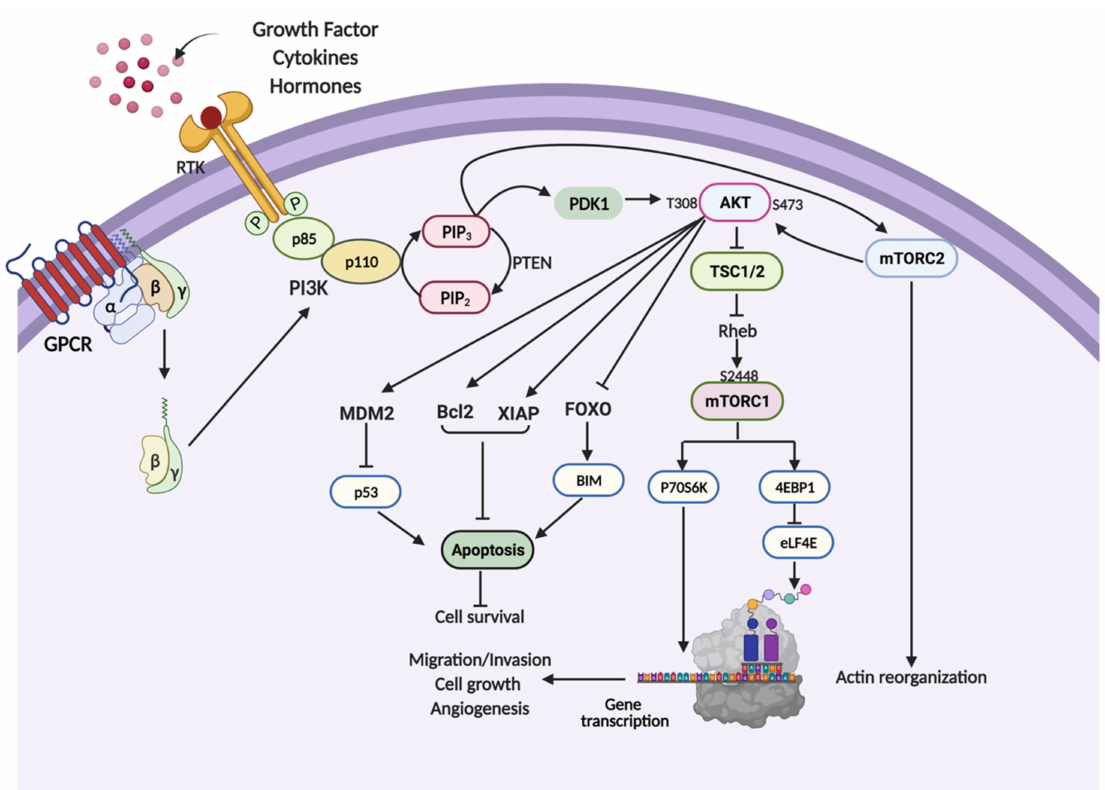
Figure 1. Summary of the phosphoinositide 3-kinase (PI3K)/protein kinase B (AKT)/mammalian target of rapamycin (mTOR) signaling pathway (created with BioRender.com). The PI3K pathway is activated when receptor tyrosine kinases (RTKs) or G protein-coupled receptors (GPCR) bind to growth factors and lead to AKT activation. Upon activation, AKT triggers the phosphorylation of mTOR, p70S6 kinase 1 (p70S6K) and eukaryotic translation factor 4E-binding protein 1 (4EBP1), resulting in the modulation of gene transcription related to cancer aggressiveness. AKT also stimulates cell death resistance by upregulating mouse double minute 2 homolog (MDM2) and prosurvival proteins such as Bcl2 and X-linked inhibitor of apoptosis protein (XIAP) and downregulating Forkhead box O3 (FOXO3) and proapoptotic proteins. mTORC2 phosphorylates AKT and induces actin reorganization, resulting in cell